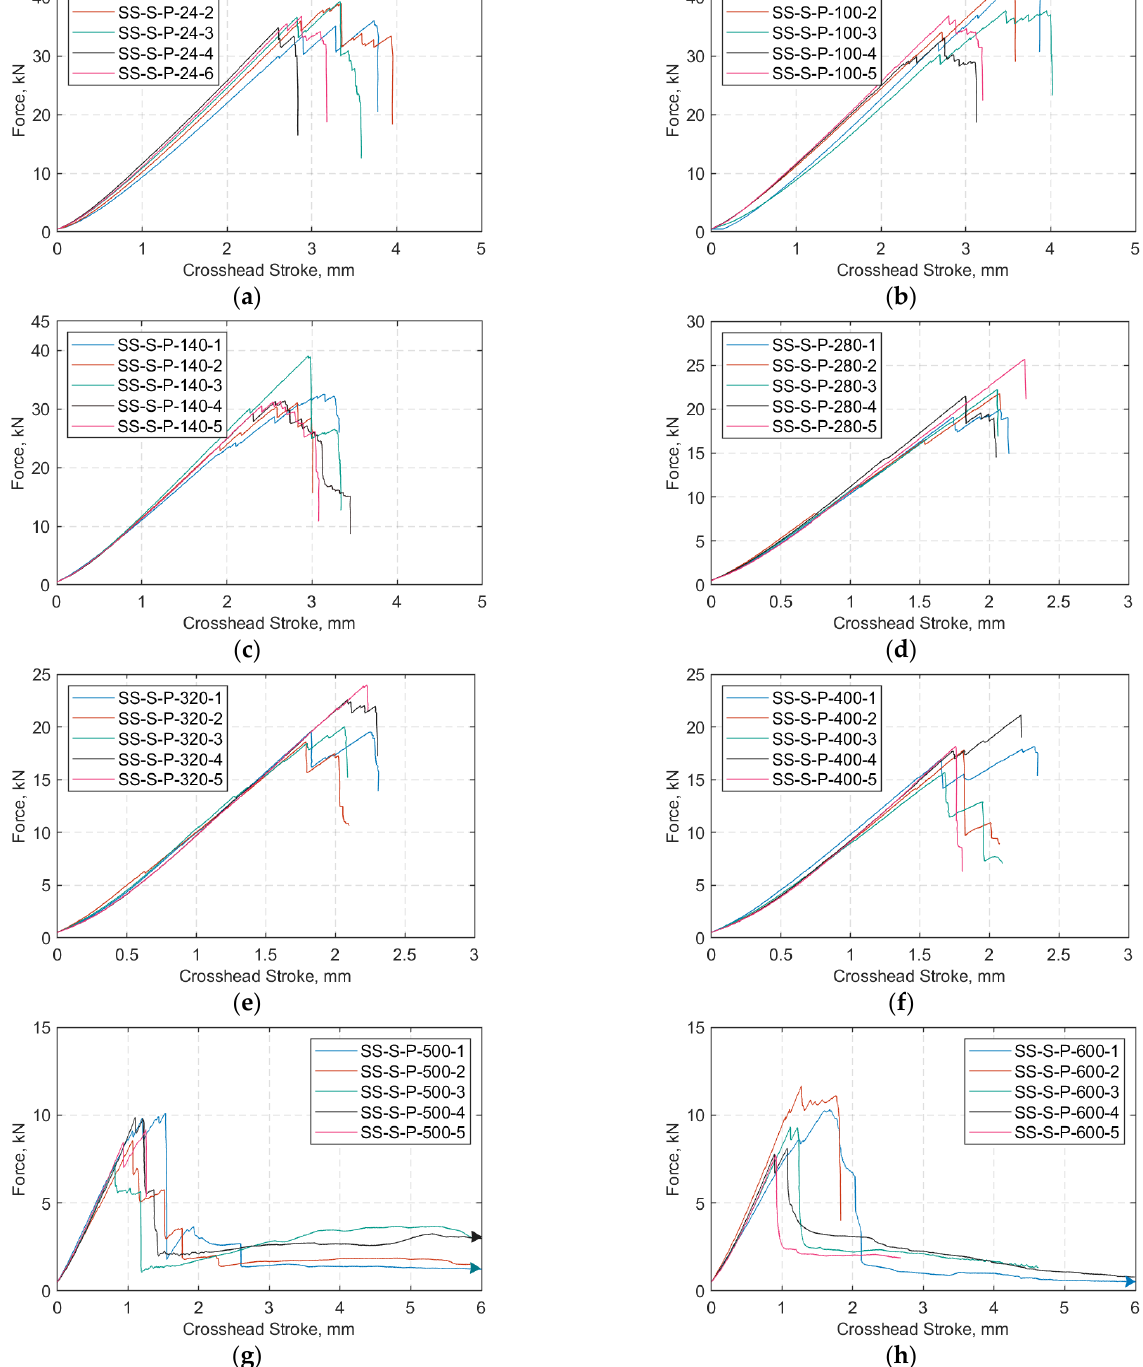
Figure A2. Load (kN) vs. crosshead stroke (mm) for all SS cases: ( a ) 24 °C, ( b ) 100 °C, ( c ) 140 °C, ( d ) 280 °C, ( e ) 320 °C, ( f ) 400 °C, ( g ) 500 °C, and ( h ) 600 °C.